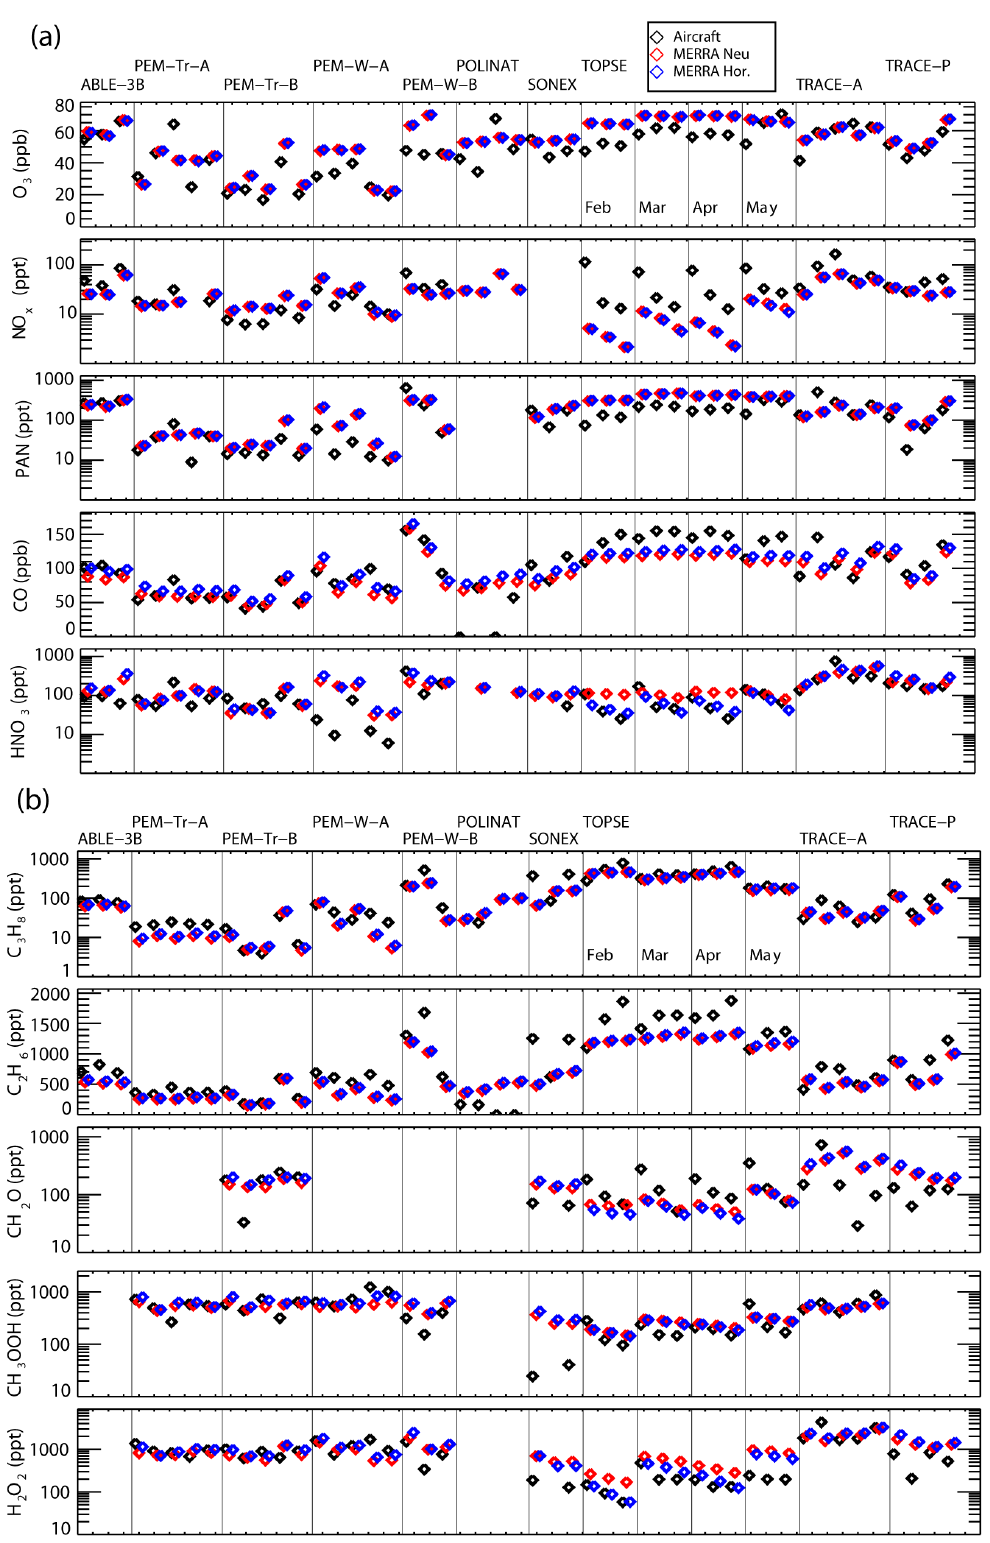
Fig. 10. (a) As Fig. 9a, except comparing the Horowitz and Neu and Prather washout schemes. (b) Same as (a) but for additional